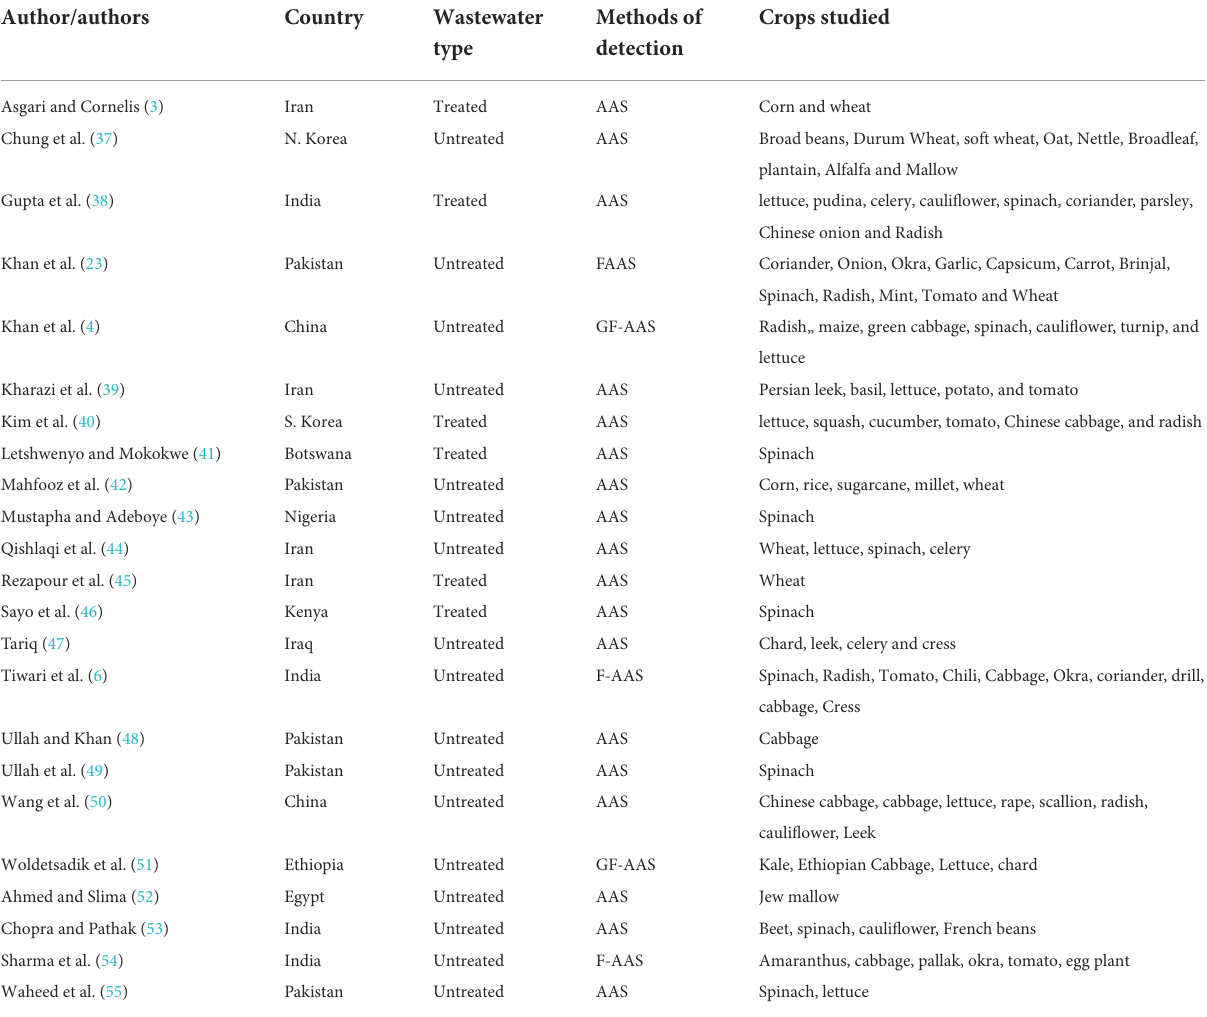
TABLE 2 Major characteristics of the studies (Author and year of the